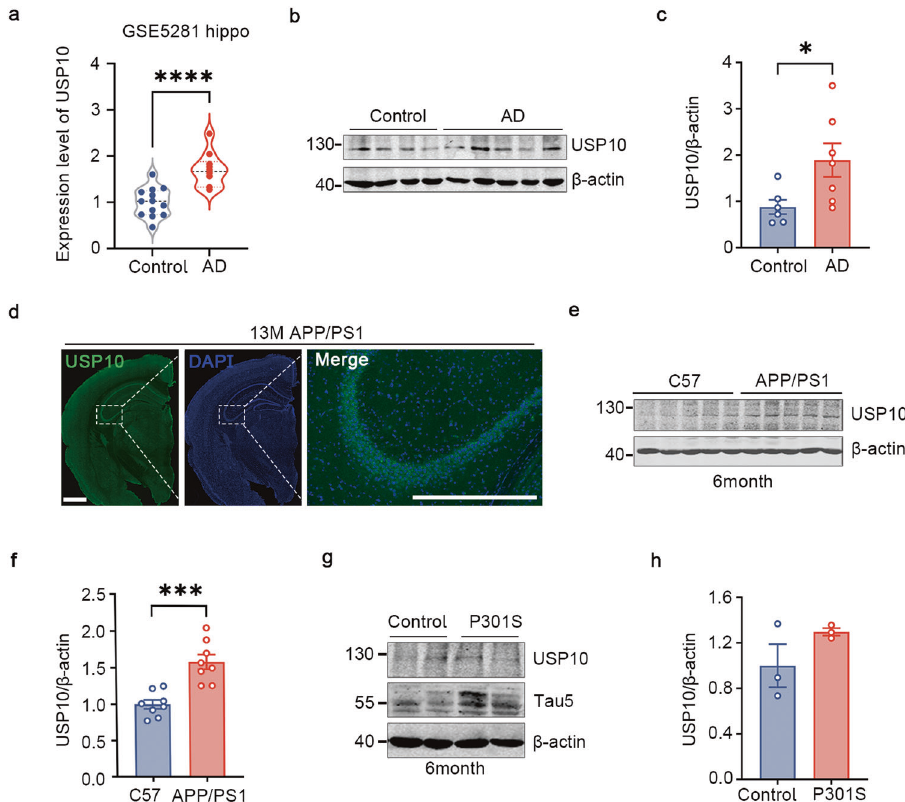
Fig. 1 USP10 is signi fi cantly increased in AD. a Analysis of USP10 differentially gene expression level of GSE5281. b The level of USP10 in the postmortem hippocampus brain was measured by western blotting (WB). c Densitometry of WB shows a signi fi cant increase in AD compared to control. n = 6 control and 7 AD. d Immuno fl uorescence staining of USP10 in 13-month APP/PS1 mice. Scale bar = 500 μ m. e , f The level of USP10 was signi fi cantly increased in the hippocampus of 6-month-old APP/PS1 mice, n = 8. g , h USP10 and Tau5 were detected in the hippocampus of 6-month-old P301S mice; n = 3. All data represent mean ± SEM, p -value signi fi cance is calculated from an unpaired two-tailed t-test. * P < 0.05, *** P < 0.001, **** P < 0.0001 vs